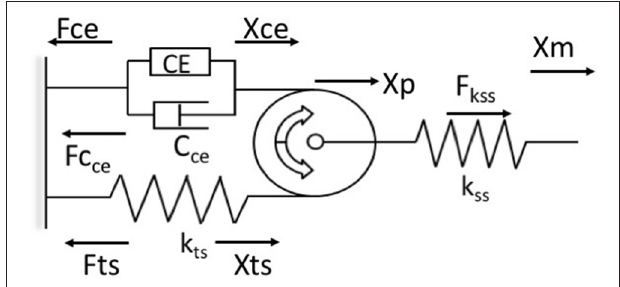
FIGURE 1 | Schematic representation of the muscle model based on the winding filament hypothesis (WFH). The contractile element (CE) is a linear motor with displacement (Xce) and force (Fce). The force velocity relationship of the contractile element is approximated by a viscous damper (C ce ), with different coefficients for lengthening and shortening. A massless, dimensionless pulley represents the thin filaments in muscle sarcomeres. The pulley translates (X p ) due to applied forces that stretch or shorten the muscle (X m ). The titin spring (k ts , Fts) is wound around the pulley by activation of the CE and unwinds during deactivation. The titin spring is elongated (X ts ) by applied forces that translate the pulley toward or away from the contractile element. The series spring (k ss , F ss ) represents muscle tendons, aponeuroses and other series elastic elements. Arrows indicate positive direction. See text for further explanation and